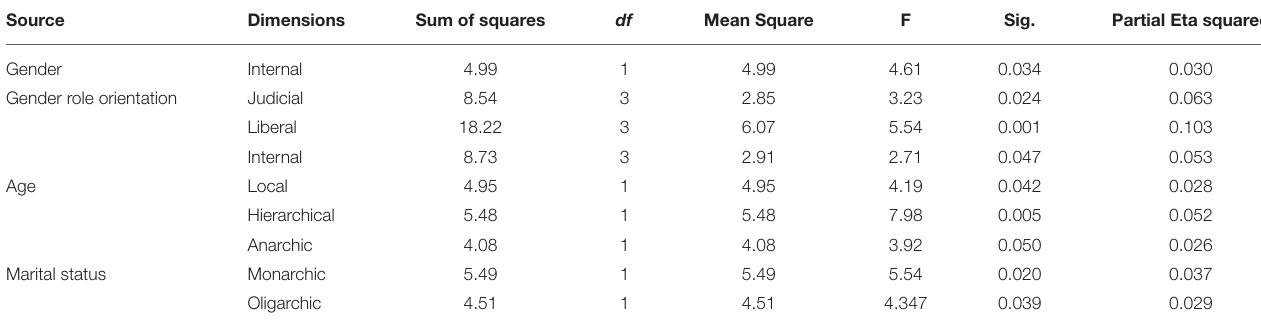
TABLE 2 | Influential roles of demographic factors on thinking styles. Source Dimensions Sum of squares df Mean Square Sig. Gender